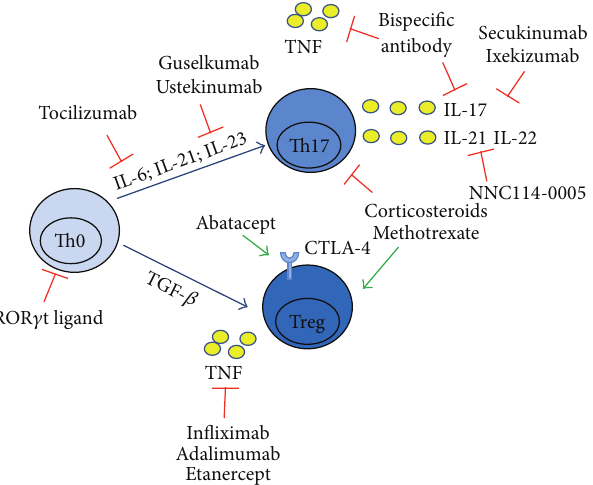
Figure 1: Therapeutic targeting of Treg and Th17 cells in rheumatoid arthritis (RA). The figure displays currently employed therapeutic approaches in RA for which an effect on Treg and Th17 cells has been reported in the literature (see text for details). Other compounds depicted in the figure are currently under investigation in RA or have been tested in experimental models of the disease. CTLA-4: cytotoxic T lymphocyte antigen 4; IL: interleukin; TGF- 𝛽 : transforming growth factor- 𝛽 ; TNF: tumor necrosis